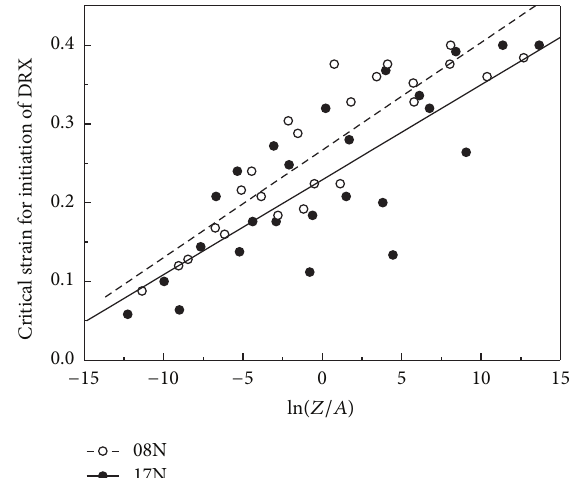
Figure 5: Dependence of the critical strain for the initiation of DRX on the 𝑍 parameter in the tested